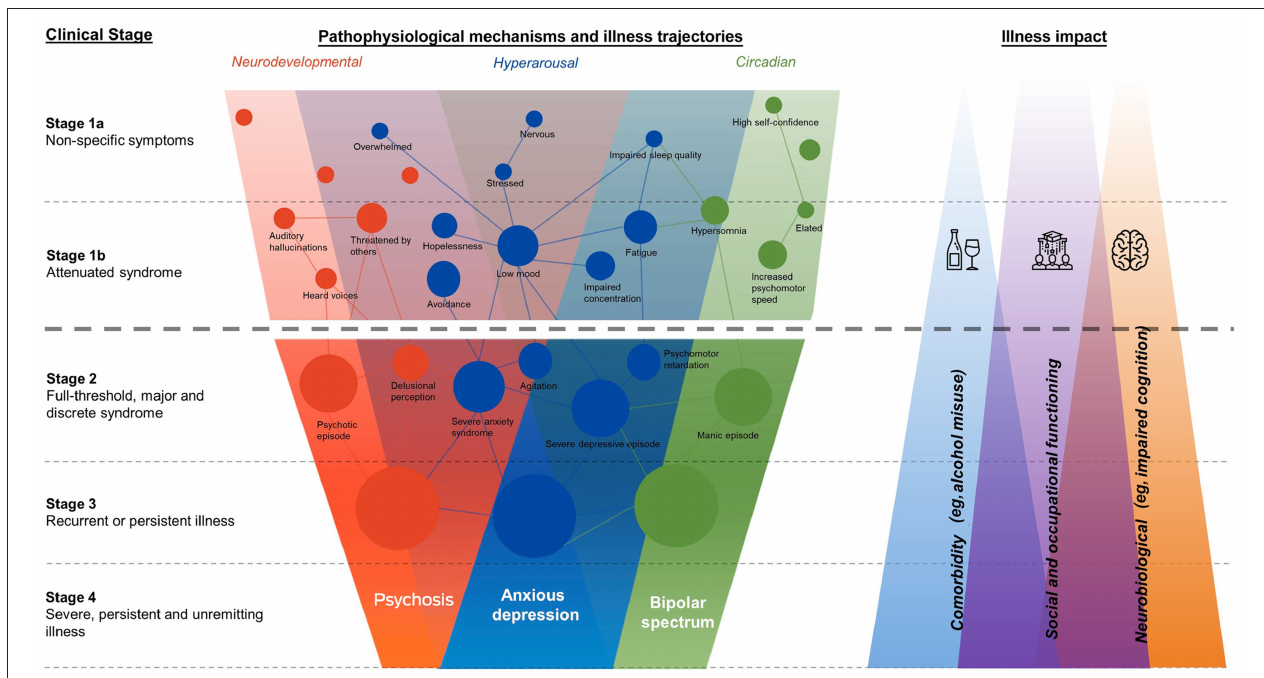
FIGURE 1 | Transdiagnostic framework of clinical stages overlapping pathophysiological domains, and theorized magnitude of illness impacts (19).